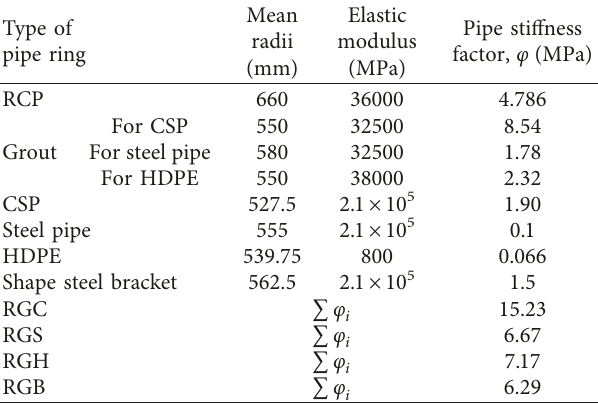
Table 1: Stiffness factors of the tested pipes.